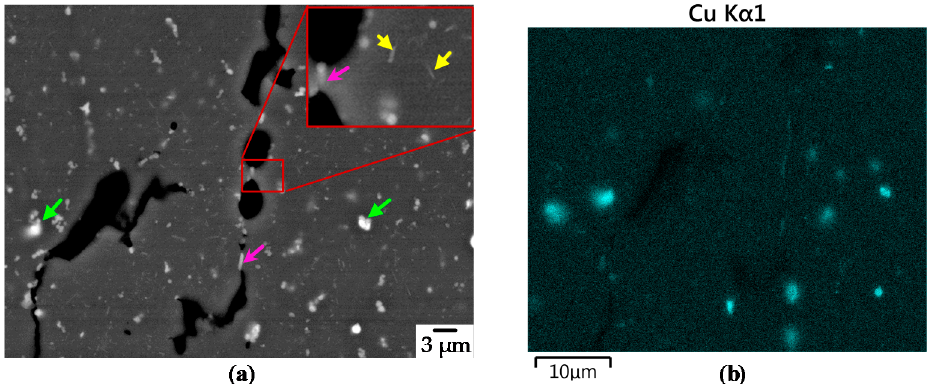
Figure 13. AsB Picture for sample Figure 7b. Purple arrows mark Cu rich or θ -Al 2 Cu Phase, yellow plate-shaped θ -Al 2 Cu (EHT = 20 kV, WD = 8.7 mm, IProbe = 1.5 nA, ESB Grid 1000 V).